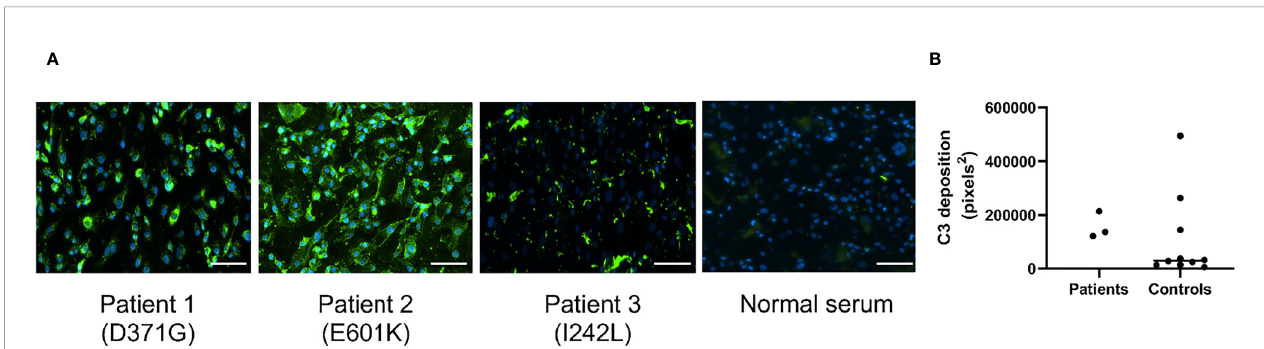
FIGURE 2 | C3 deposition on glomerular endothelial cells in the presence of serum from patients and controls. Sera from Patients 1-3 and controls (n = 10) were incubated with glomerular endothelial cells for 2 h and C3 detected by immuno fl uorescence. (A) Serum from Patients 1-3 induced excessive C3 deposition on the cells. The scale bar represents 100 µm. (B) Quanti fi cation of C3 deposition fl uorescence showing that even 3/10 sera from apparently healthy adult controls exhibited C3 deposition. The bar represents the median.